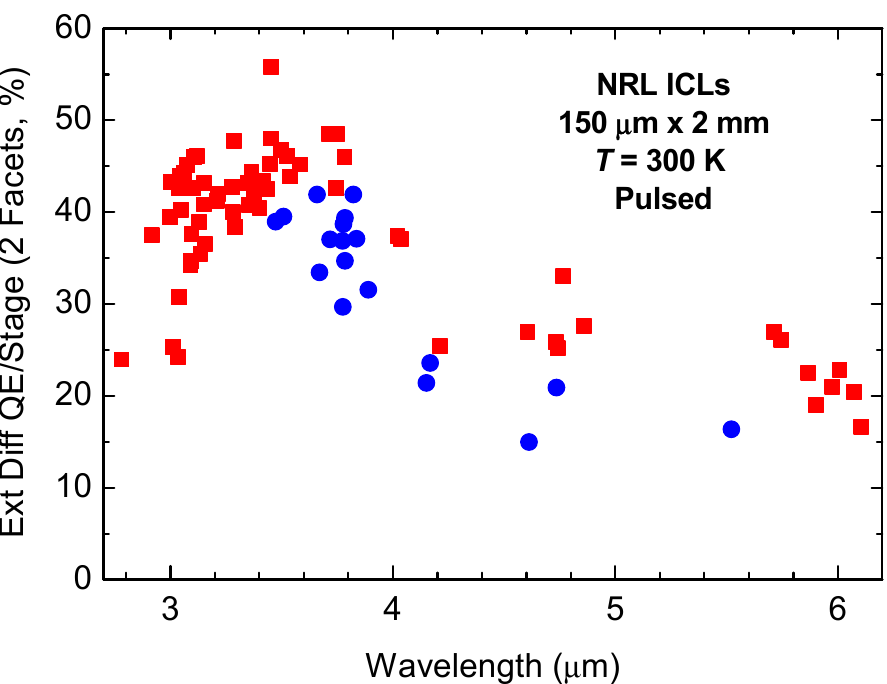
Figure 6. Pulsed external differential quantum efficiency above the lasing Table 300. K as a function of emission wavelength, for the same NRL broad-area ICLs as in Figures 4 and 5. Again, blue points represent 5-stage devices, while red points indicate devices with ≥ 7 stages.